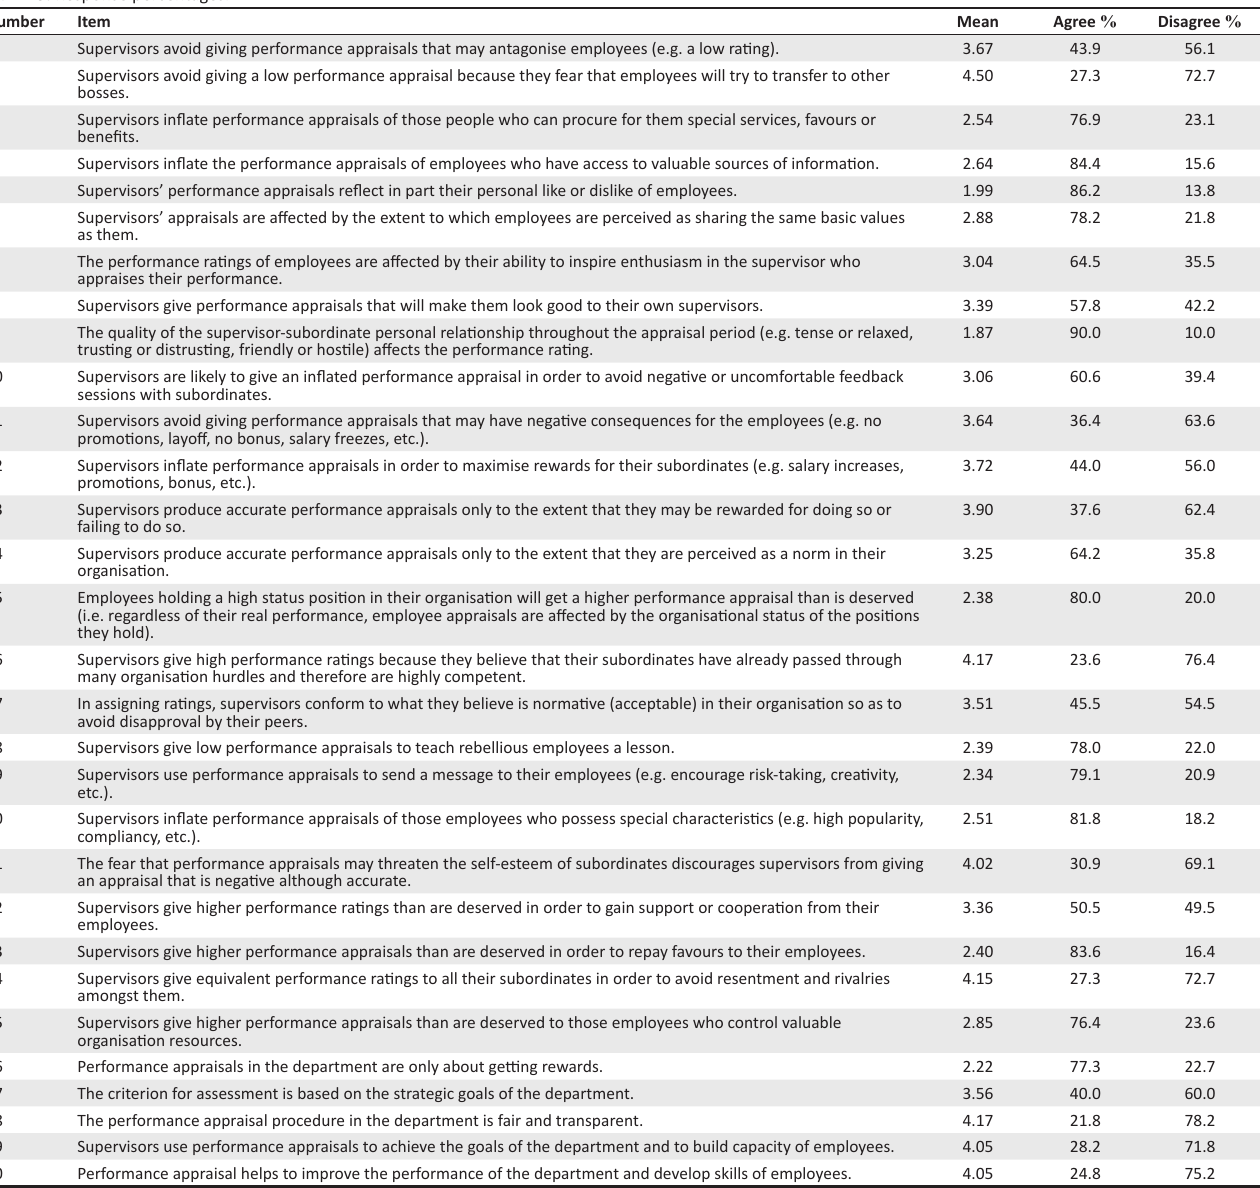
TABLE 3: Response percentages.